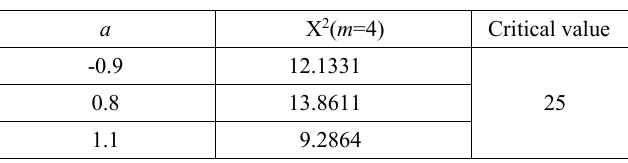
Table 3. Results of poker test.